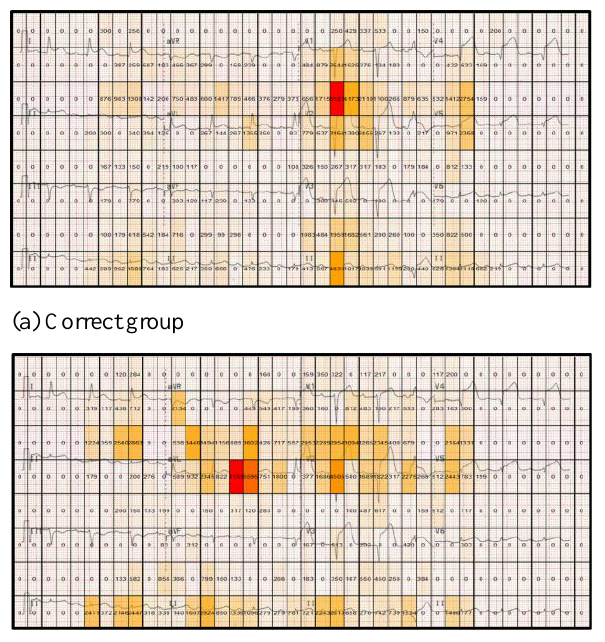
Figure 8. Heatmaps showing the total fixation duration in each grid cell for the anterolateral STEMI stimulus Finally the transitions between the leads (V1-V4) pre- senting the most relevant salient information (highest degree of ST-segment elevation) are computed for both of the groups. Figure 9 shows the number of transitions from one lead to another or within the same lead itself. The number of transitions is represented by the thickness of the arrow, with the arrow point showing the direction of the transition (from - to). The actual number of transi- tions is also displayed on arrow heads. The incorrect group made a greater number of overall transitions (n=2307) than the correct group (n=2146).